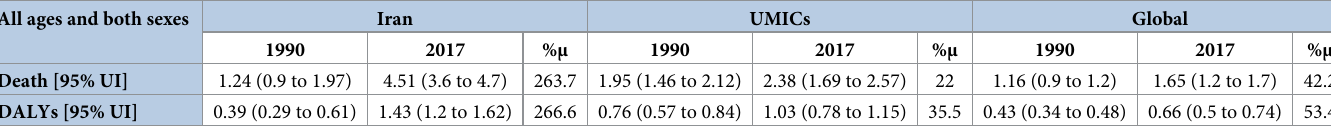
Table 6. Death and DALYs percentage of HHD in all ages and both sexes in 1990 and 2017 in Iran, UMICs and globally for all causes. All ages and both